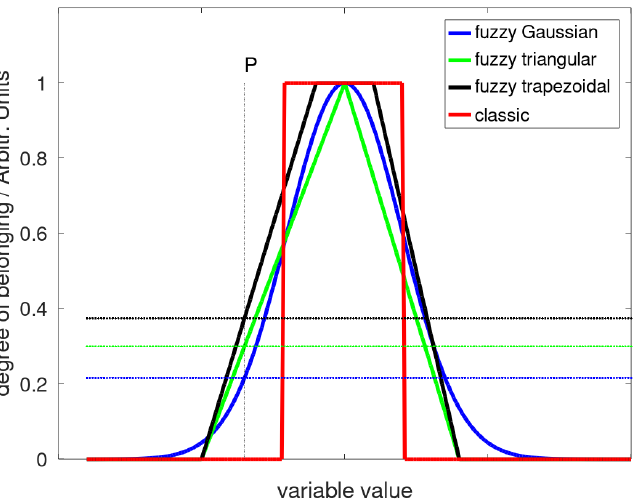
Figure 3. Fuzzy membership functions and degree of belonging of the variable P. The value assumed by the FMF at abscissa P represents the belonging to that set. In this case, while P has belonging 0 in the classic dataset (red), it shows a belonging of 0.226 to the Gaussian FMF function (blue), 0.300 to the triangular FMF function, and 0.375 to the trapezoidal FMF (black).